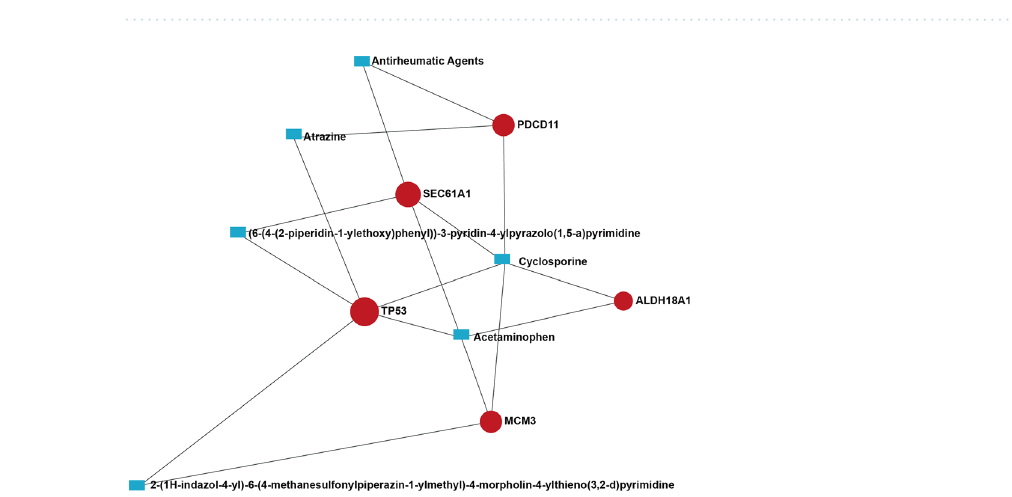
Figure 6. TF-gene interactions and gene-miRNA networks. ( A ) The TF-gene interaction network. Red spots represent hub genes; blue spots represent TFs. ( B ) The gene-miRNA network. Red spots represent hub genes; blue rectangles represent miRNAs. ( C ) GO and KEGG analysis for the TF-gene interaction network displayed in the form of histogram. ( D ) Heatmap of expression correlation in severe asthmatics from GSE69683. Five hub genes and TFs in the network were analyzed using Spearman method.